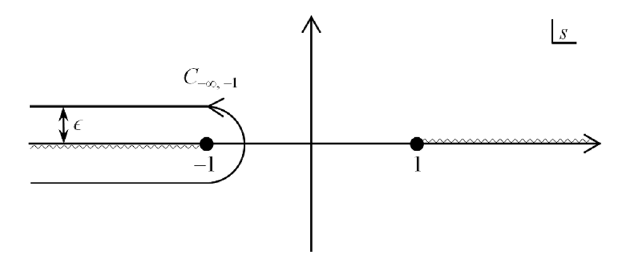
Figure 1 . The contour around ( (cid:0)1 ; (cid:0)